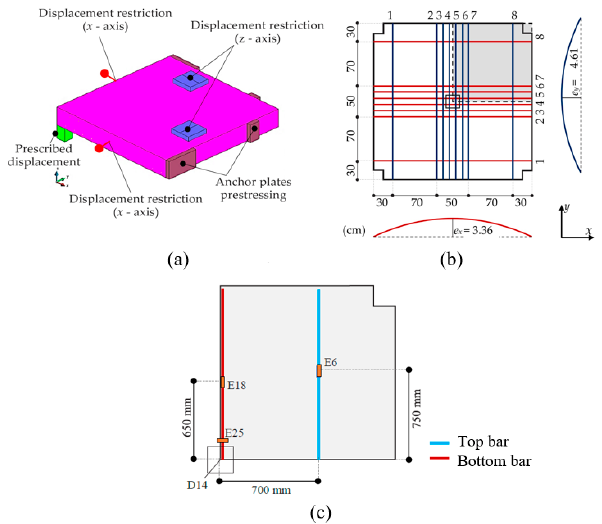
Figure 9. ( a ) Numerical model M4 and boundary conditions, ( b ) Characteristics of the experimental model, ( c ) Position of extensometers on the reinforcement. Table 2. Prestressing force on tendons (kN) [1].